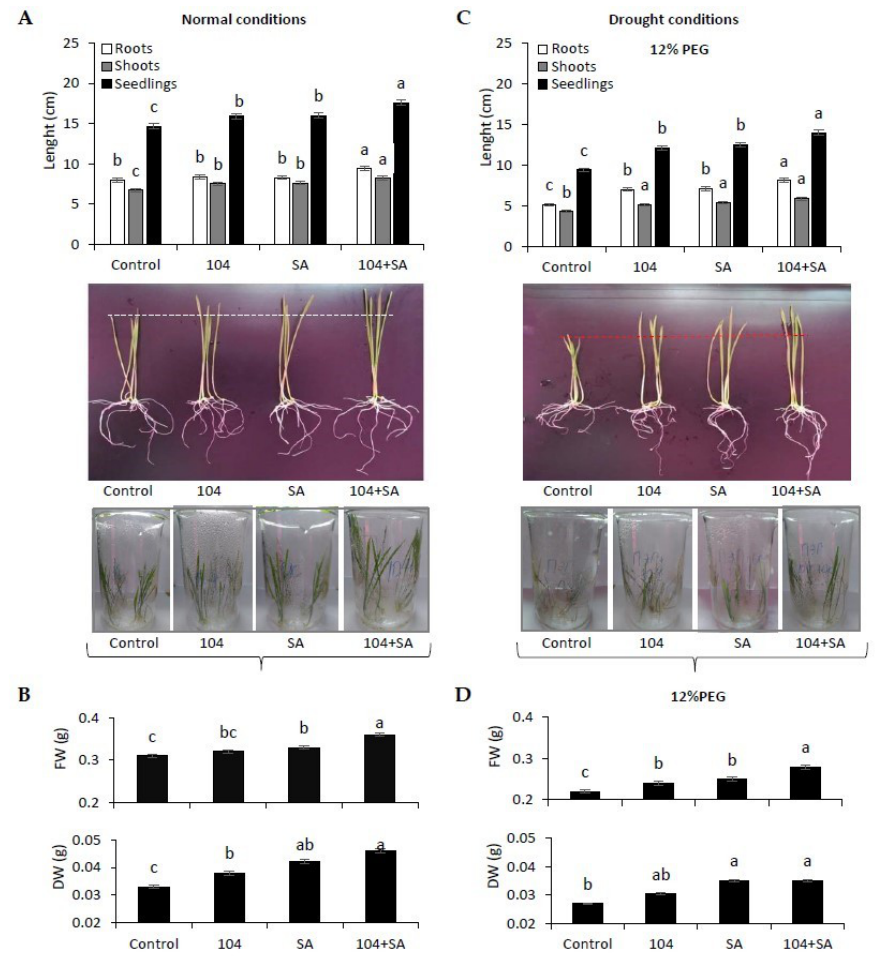
Figure 5. Effect of endophytic B. subtilis 10–4 (104) (10 5 CFU mL −1 ), SA (0.05 mM), and composition of B. subtilis 10–4 + SA (104+SA) on the linear dimensions (root and shoot lengths) and fresh weight (FW) and dry weight (DW) biomass accumulation of wheat seedlings under normal ( A , B ) and drought stress (12% PEG) conditions ( C , D ). Fourteen-day-old seedlings; drought stress (12% PEG) exposure time—11 days. Control—plants without treatments; 104, SA, and 104 + SA—plants pre-treated with B. subtilis 10–4, SA, and B. subtilis 10–4 + SA, respectively. The error bars show the average of